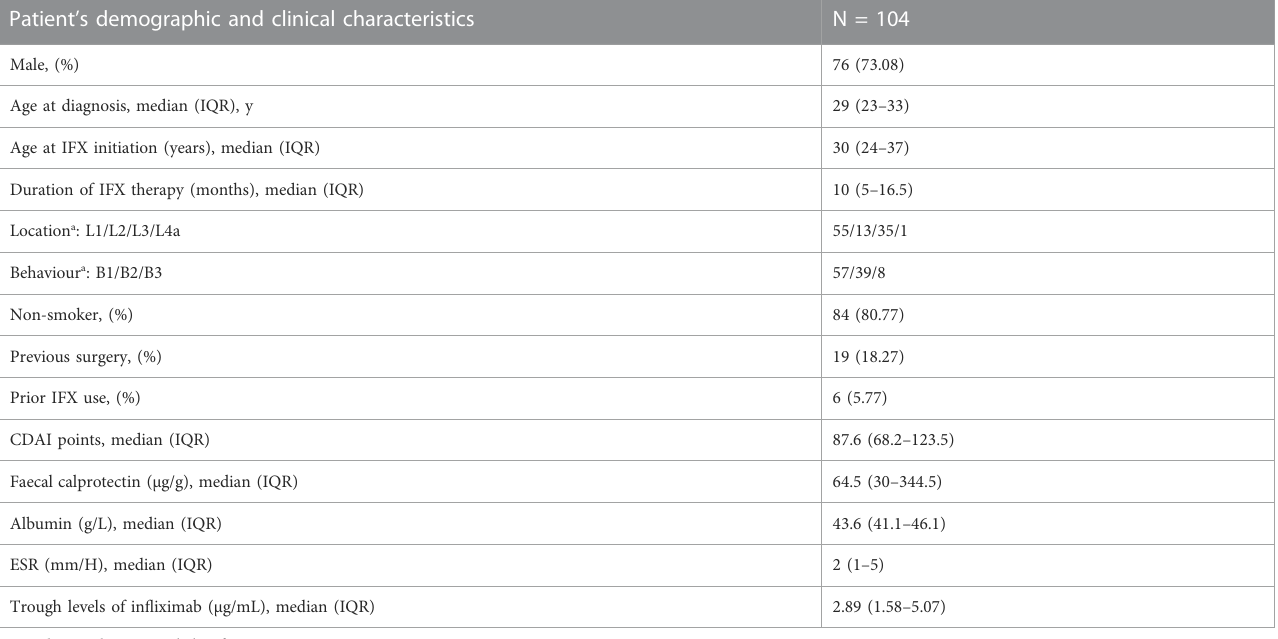
TABLE 1 Patients ’ demographic and clinical characteristics. Patient ’ s demographic and clinical